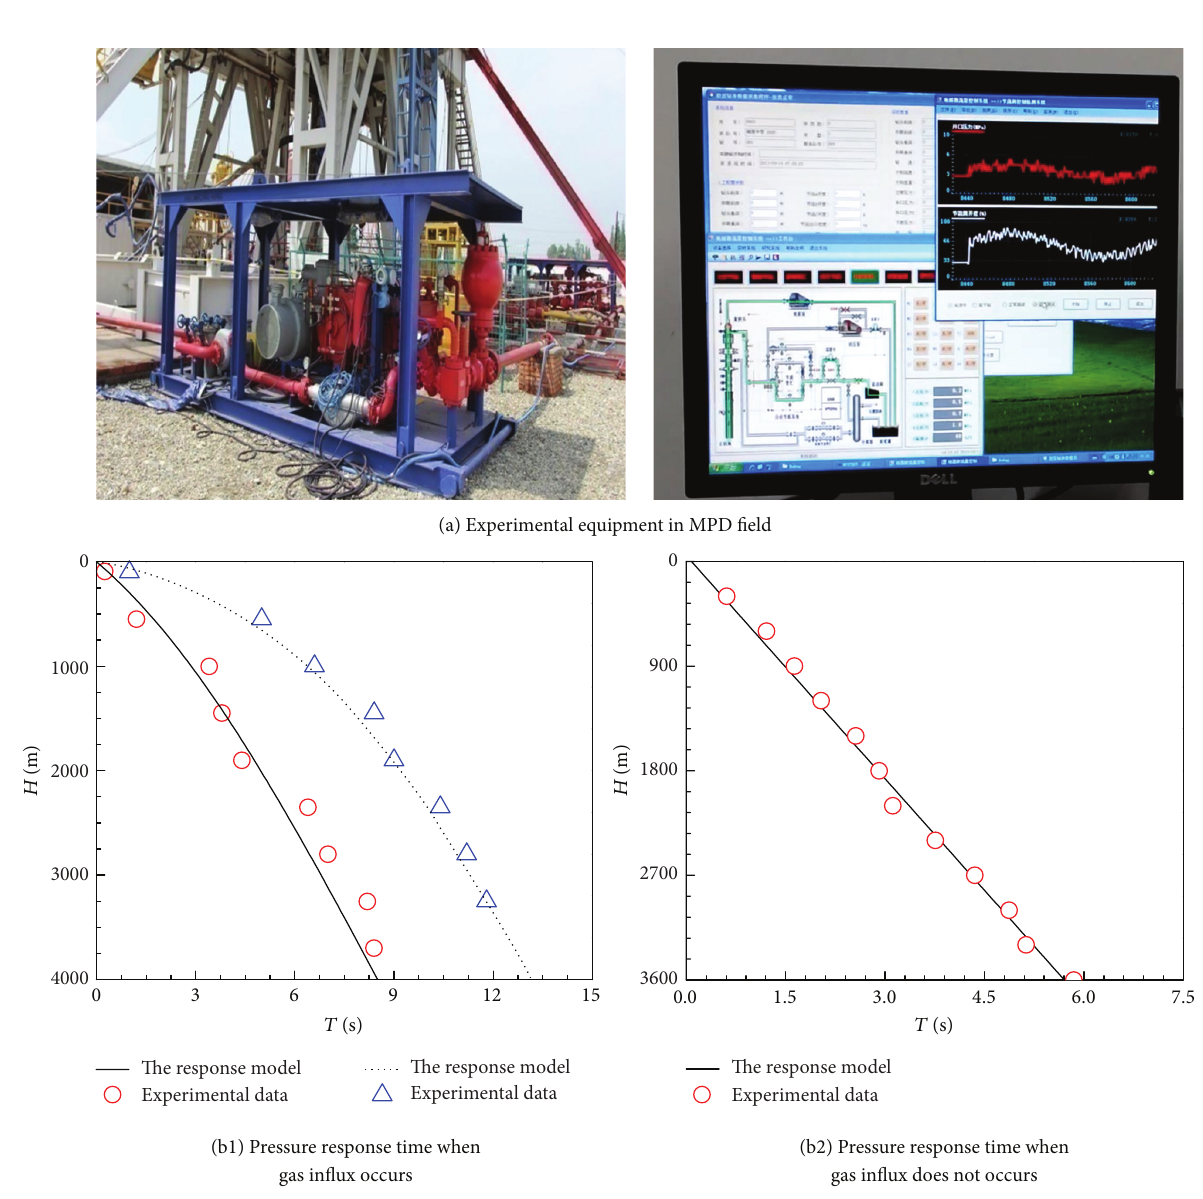
Figure 3: Experimental verification in comparison with field